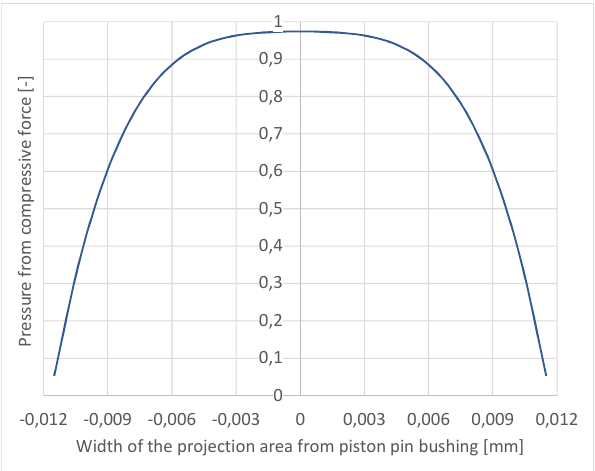
Fig. 4. Function graph describing the pressure distribution on the sur- face of the rod bushing